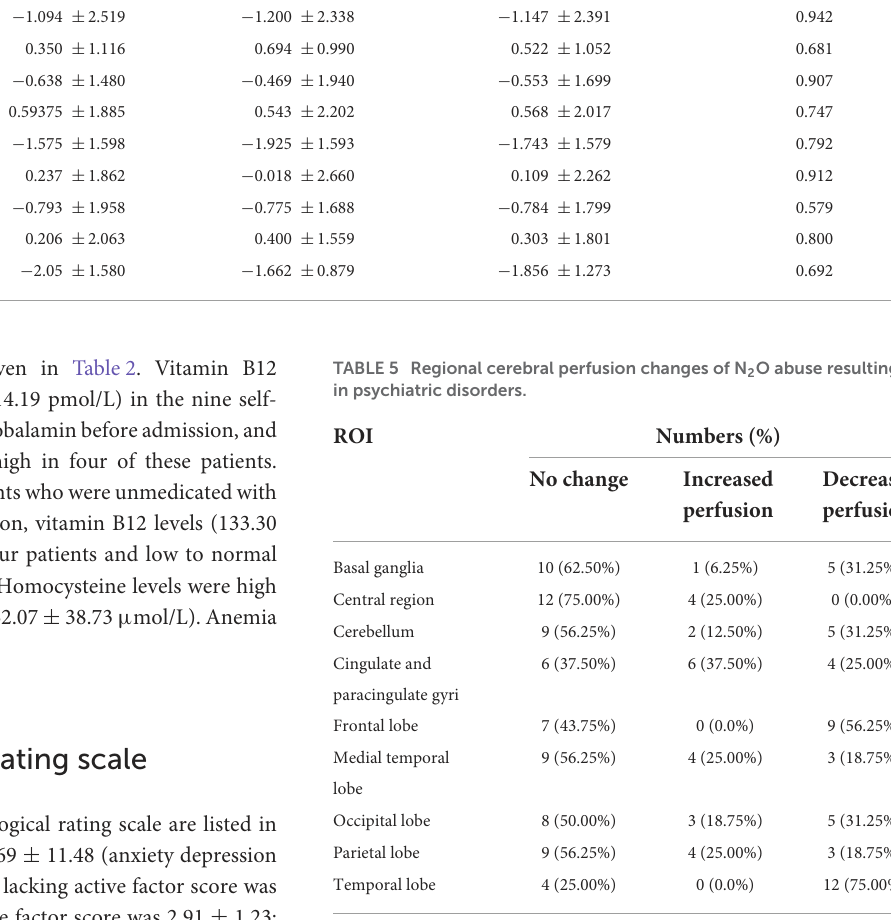
TABLE 4 Regional uptake statistics of 99m TC-ECD between patients and normal people of the same age group. ROI Left (Mean ± SEM) Right (Mean ± SEM) Average (Mean ± SEM) Basal ganglia